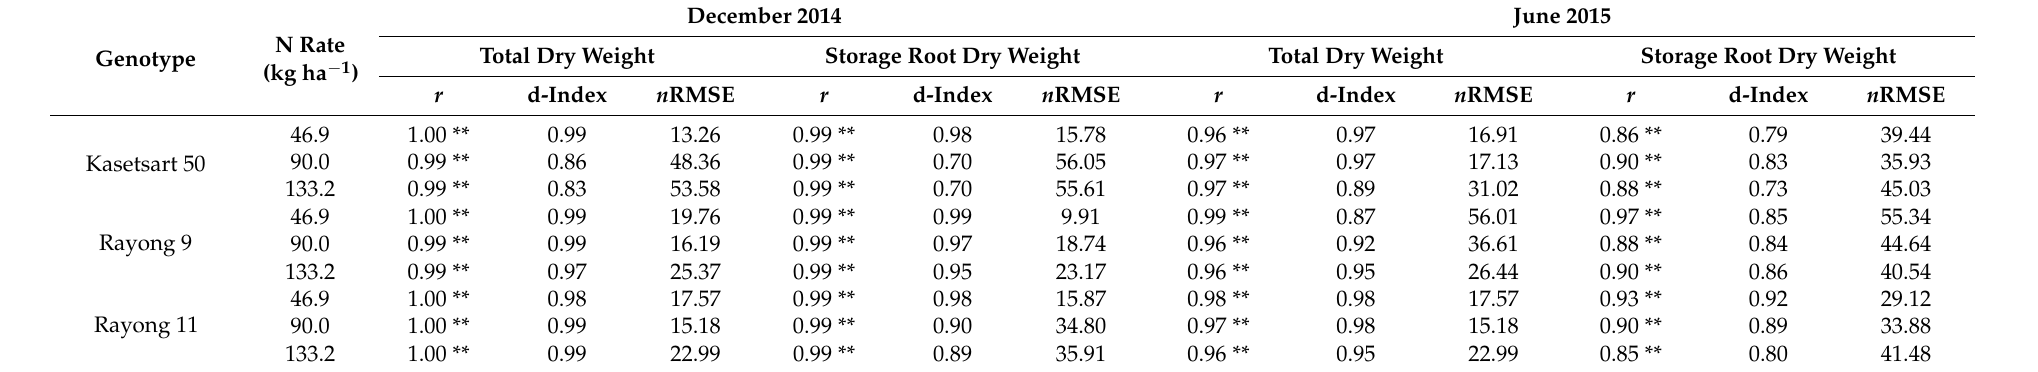
Table 2. The Pearson correlation coefficient ( r ), index of agreement (d-index), and normalized root mean square error ( n RMSE) values for evaluation of the CSM–MANIHOT–Cassava model based on total and storage root dry weights for the three cassava genotypes under three different rates of nitrogen application on December 2014 and June 2015 planting